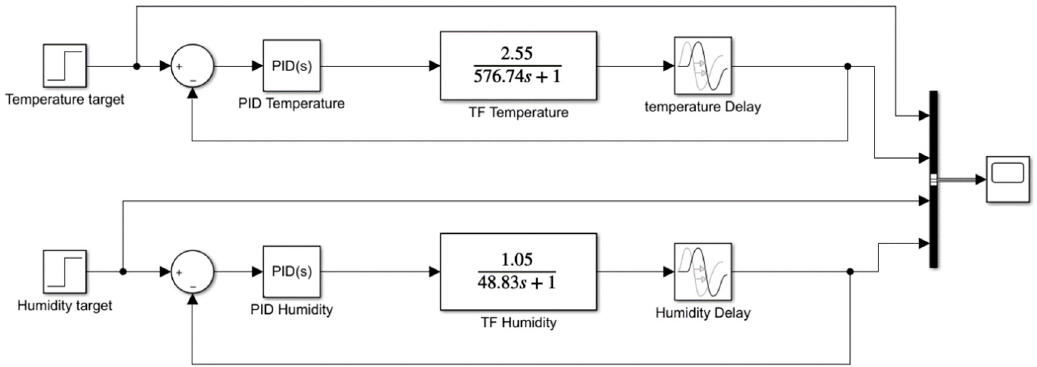
Figure 10. System block diagram with temperature and humidity.